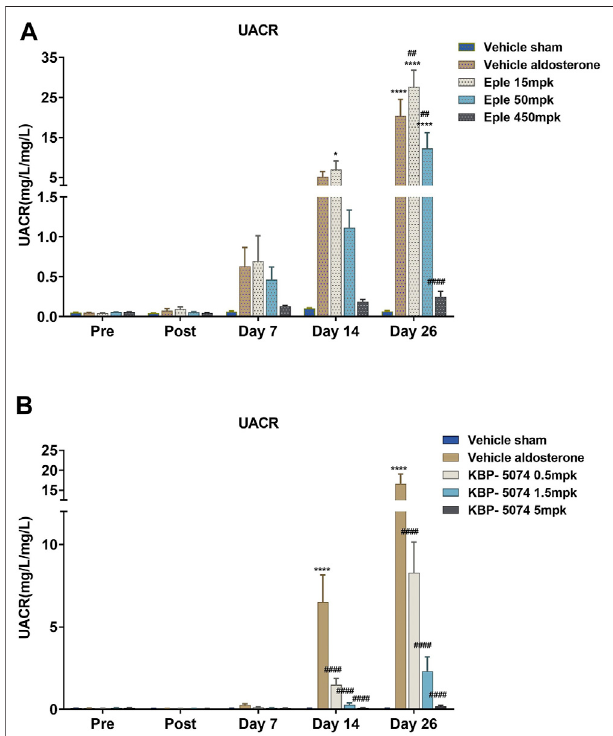
FIGURE 1 | Effects of eplerenone and KBP-5074 on UACR. (A) Eplerenone: Values are expressed as mean ± SEM. n (cid:2) 11 – 13. * p < 0.05, **** p < 0.0001 vs. Vehicle Sham group, ## p < 0.01, #### p < 0.0001 vs. Vehicle Aldosterone group followed by two-way ANOVA Tukey ’ s multiple comparisons test. (B) KBP-5074: Values are expressed as mean ± SEM. n (cid:2) 11 – 13. **** p < 0.0001 vs. Vehicle Sham group, #### p < 0.0001 vs. Vehicle Aldosterone group followed by two-way ANOVA Tukey ’ s multiple comparisons test. Eple,eplerenone; SEM, standarderrorofthemean;UACR, urinary albumin-to-creatinine